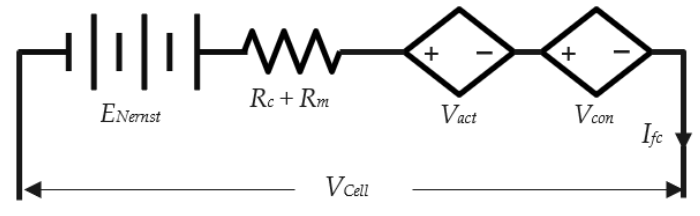
Figure 1. Electrical model of PEMFC.